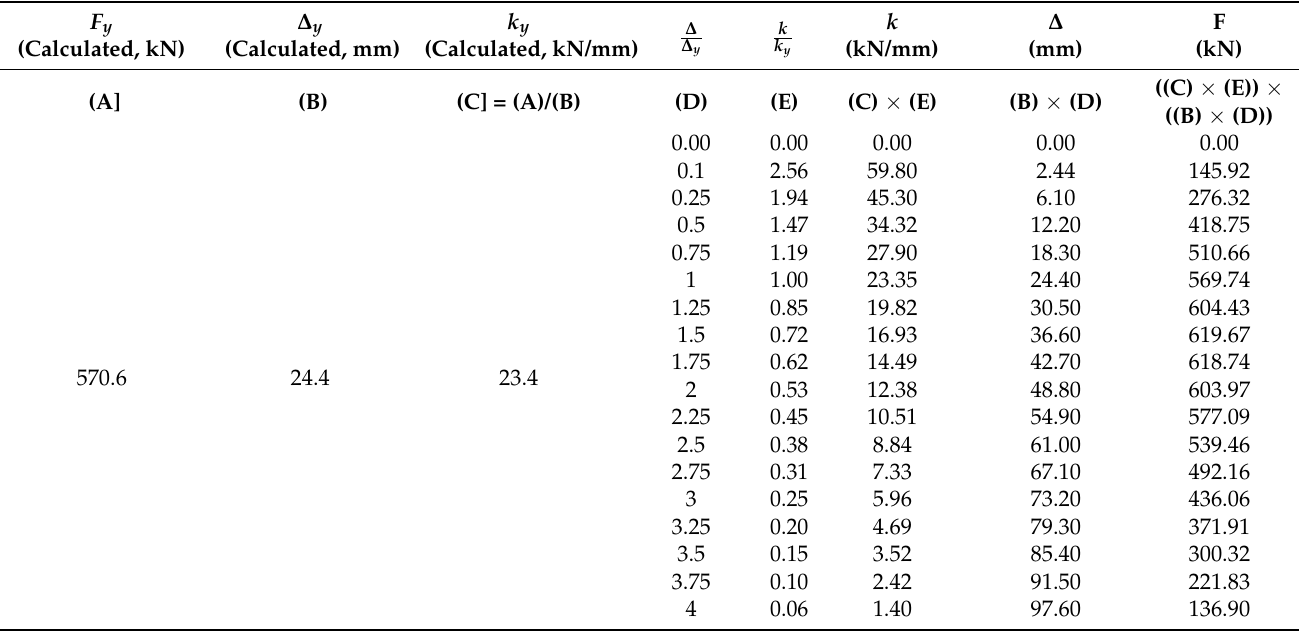
Table 4. Post-yield deflection of pre-stressed Specimen #8, along with degradation of the fixed-end pre-stressed composite (cid:16) ∆ (cid:17) = − 0.677 ln + 0.9985, Table 3, Figure 4c-1) beam, ( k ∆ k y y